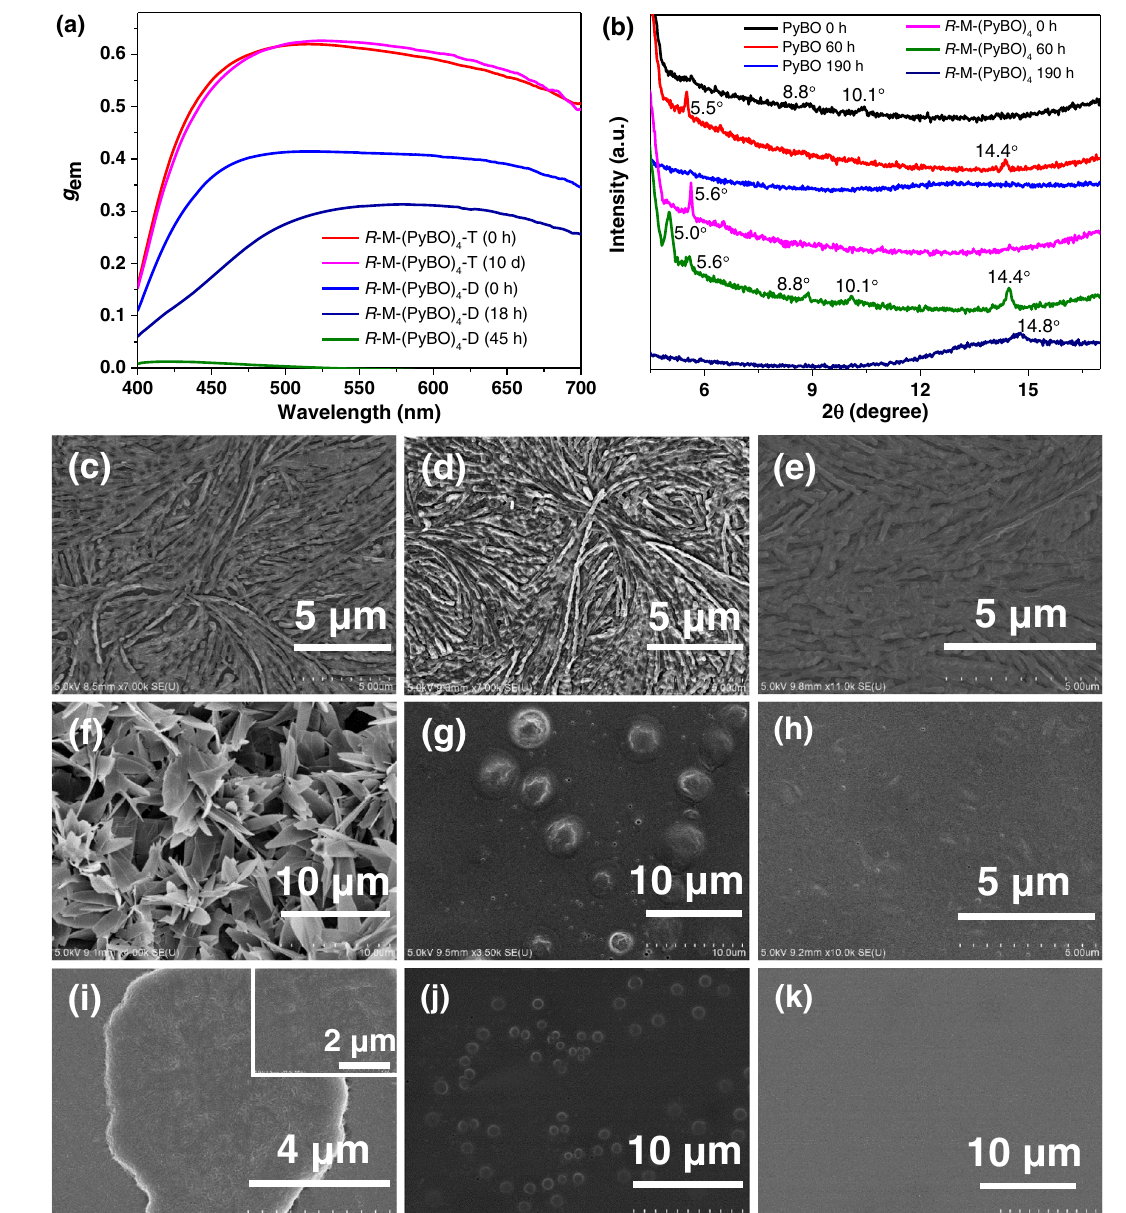
Fig. 5 | Chiral optical properties, the morphology study, and XRD patterns. a The g em values of chiral co-assemblies R -M-(PyBO) 4 -D/T ( λ ex =330nm); b XRD patternsofPyBOand R -M-(PyBO) 4 fi lmsspin-coatedfromtoluenesolution;theSEM images of c – e R -M fresh fi lms and f – h PyBO fresh fi lms spin-coated from toluene,